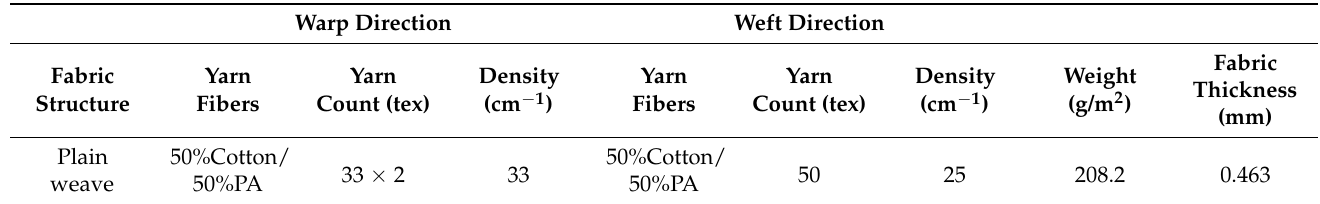
Table 2. Test results for the basic fabric